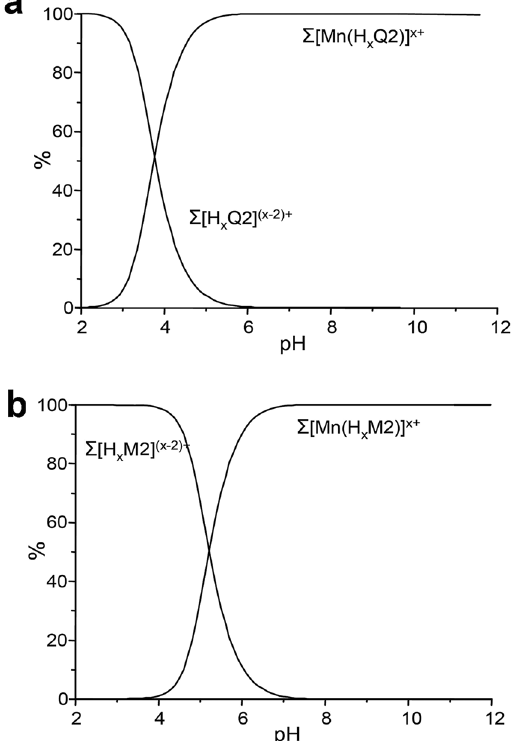
Figure 4. Overall percentages of the H 2 M2 ( a ) and H 2 Q2 ( b ) complexed species with Mn II , Ca II Mg II and Na I as a function of pH in competitive systems containing Mn II (1 μ M), Ca II , (2.5 mM), Mg II (1.5 mM) and Na